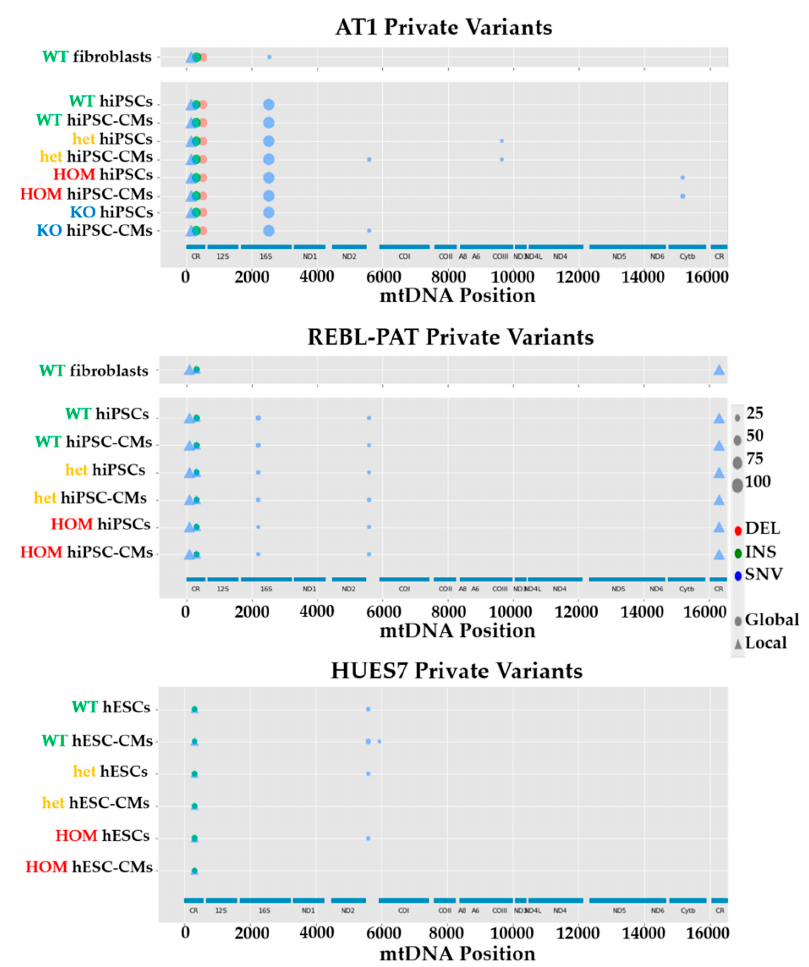
Figure 2. mtDNA NGS of three separate isogenic sets bearing the p.R453C- β MHC mutation. Analysis of mtDNA sequence of isogenic sets of fibroblasts, hPSCs and hPSC-CMs of AT1 (top), REBL-PAT (middle) and HUES7 (bottom) identified variants specific to the starting cell sources. Legend map on the right side indicates type of mtDNA mutation (DEL, deletion; INS, insertion; SNV, single nucleotide variant) and percent heteroplasmy is correlated with the size of the symbol (WT, wild- type; het, heterozygous; HOM, homozygous; KO, knock-out).